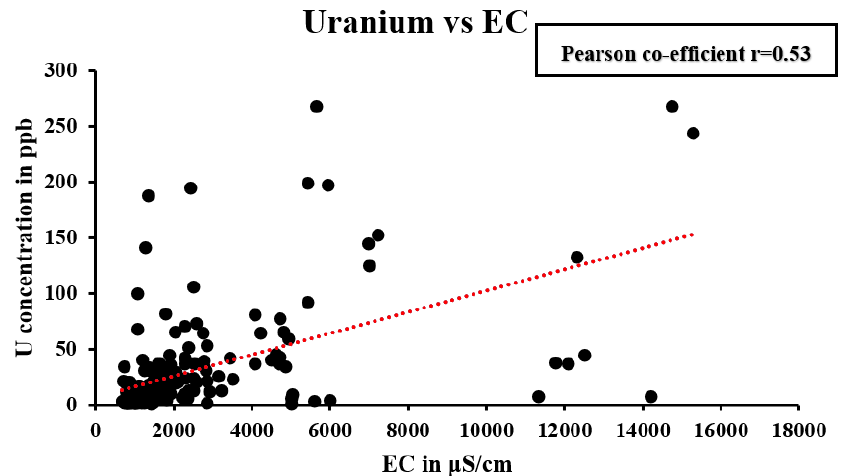
Figure 7. Pearson correlation between uranium concentration and EC.